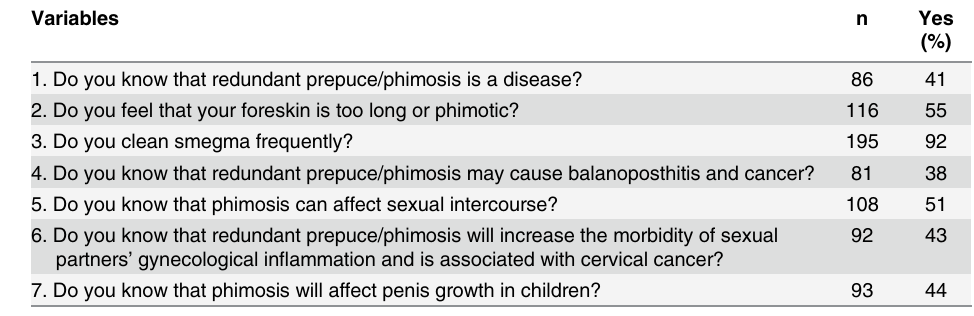
Table 2. Knowledge of Chinese men regarding redundant prepuce /phimosis.